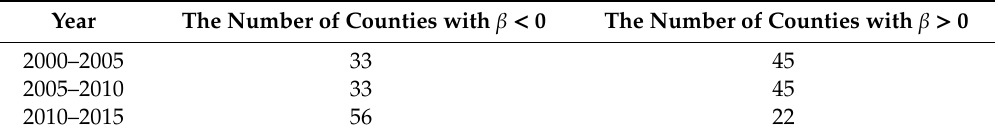
Table 3. The number of counties with di ff erent β .